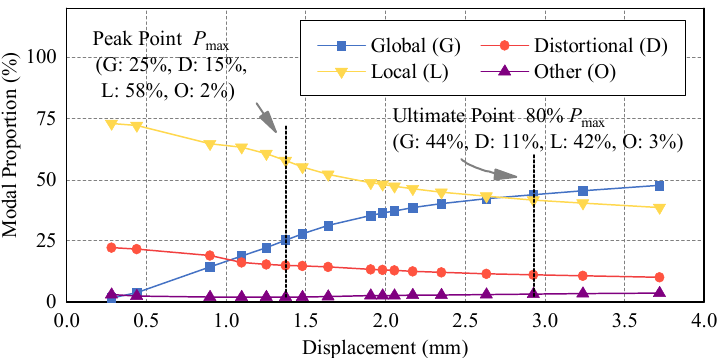
Figure 6. Full range modal participation of member FE simulation (member cross-section parameter is No. 1, 2 mm thick, 300 mm long).